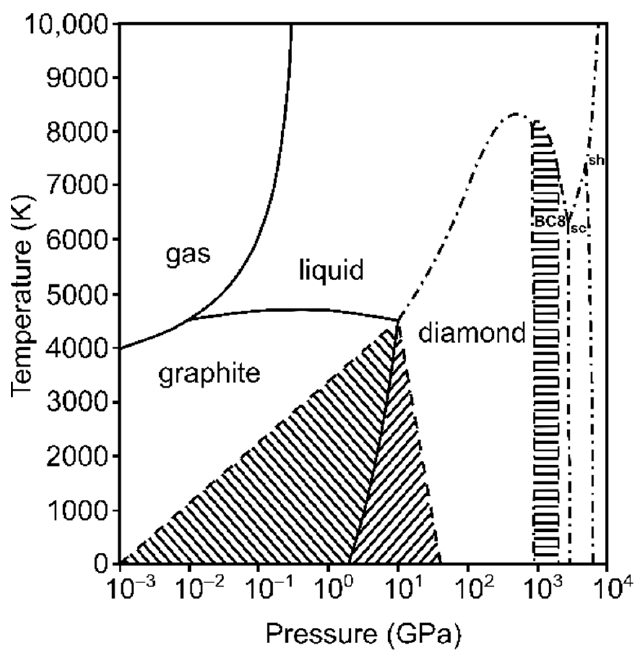
Figure 3. The simplified transitional P–T diagram of carbon, after [8,29–32]. Note the logarithmic scale for pressure. The left and right hashed areas correspond to the regions of metastability of graphite and diamond, with metastability boundaries marked as dashed lines. Dash-dotted contours delineate the calculated melting curve of diamond and stability fields of the predicted BC8, simple cubic (sc), and simple hexagonal (sh) phases [31], which have been never confirmed experimentally. The horizontal hashed area demonstrates the persistence of diamond in a ramp-compression experiment up to 2 TPa [32] within the predicted thermodynamic stability field of the BC8 phase. While the kinetics of the graphite ⇄ diamond transition can be very slow (at room temperature and ambient pressure, the diamond → graphite conversion timescale is longer than the age of the universe), the proposed metastability of diamond above 1 TPa is reported in the order of magnitude of nanosec- onds.